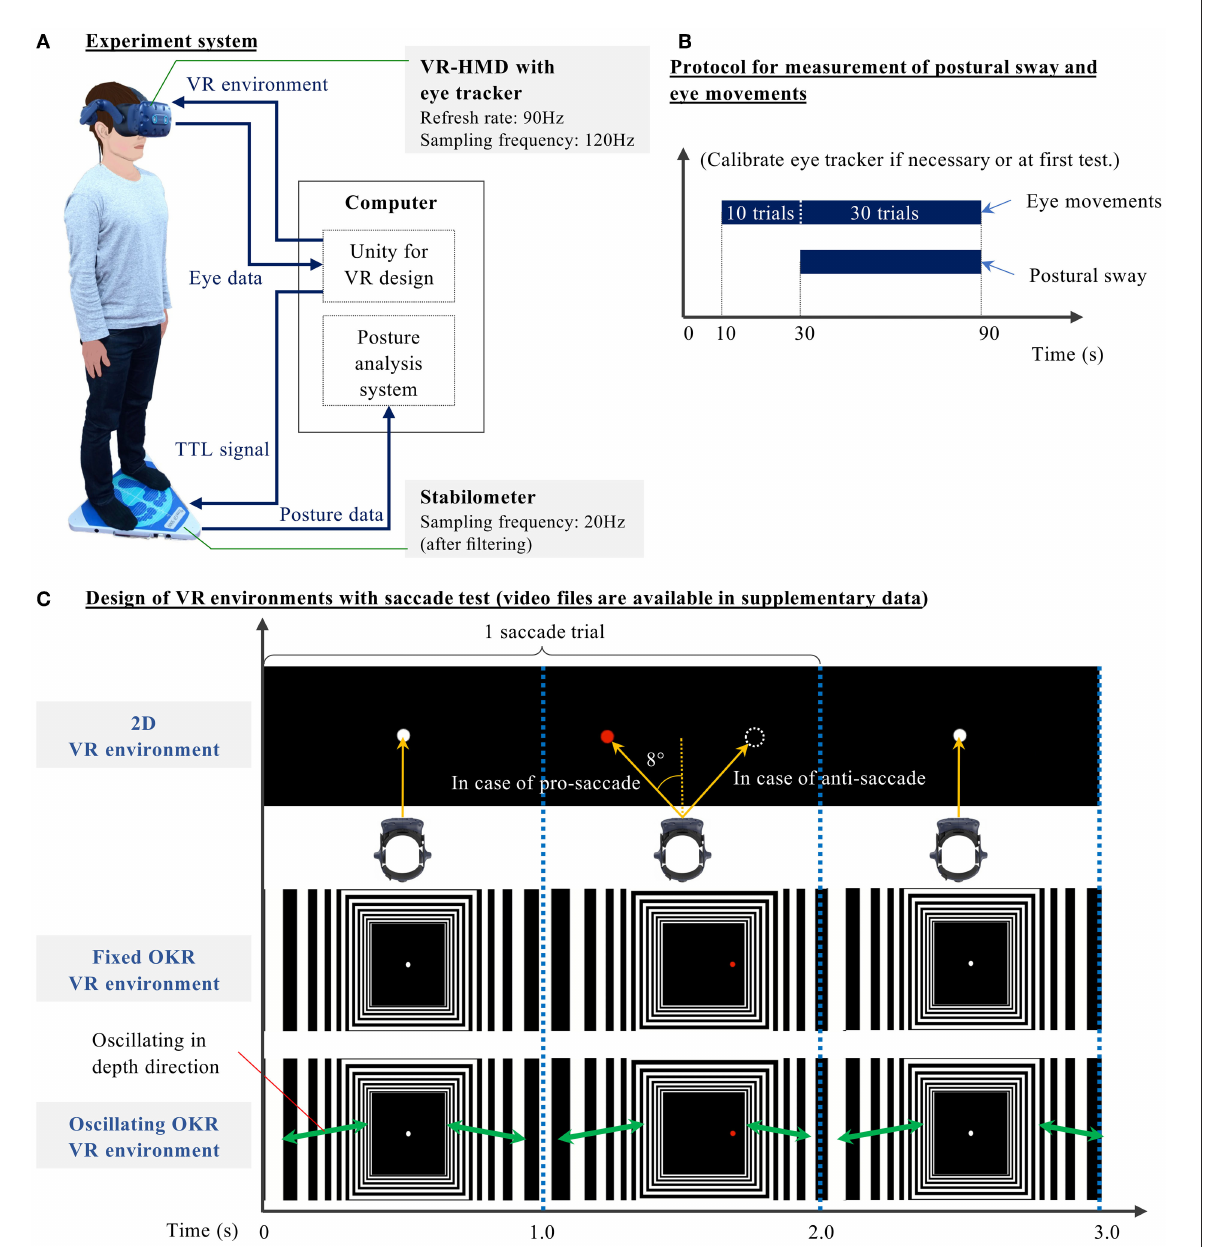
FIGURE2 (A) Block diagram of the novel concurrent comprehensive assessment system of posture and eye movements using VR-HMD—Stabilometer and analysis software: GP-5000 (ANIMA Corp., Japan), VR-HMD: VIVE Pro Eye (HTC Corp., Taiwan), Computer: NUC8I7HVK (Intel Corp., U.S.), Unity: 2019.2.5f1, Eye tracker: SRanipal 1.1.0.1, SR Runtime 1.1.2.0, and Steam VR 1.11.11. (B) Measurement protocol of posture and eye movements—1) Stand on the stabilometer, wearing the headset; 2) Look at the black screen in the VR for initial 10 s; 3) In tests without saccade, gaze at a white central target in the VR between 10 and 90 s. In tests with a saccade, perform saccadic eye movements for 40 trials (Imaoka et al., 2020b). (Postural sway is measured between 30 and 90 seconds without notice to the participants.) (C) Three VR designs were developed in this study: 2D, Fixed optokinetic design-based room with stripes (OKR), Oscillating OKR—The virtual room oscillates in depth direction for 90 s in an Oscillating OKR VR environment. In conditions with the saccade test, participants gaze at a white central target for 1 s. Once the white target disappears, the red target appears on either the left or right side at 8 ◦ . Participants move their eyes toward (for pro-saccade) or opposite of (for anti-saccade) the red target within 1 s once the red target appears. The white central target is continuously displayed in the VR for 90 s in the conditions without saccade